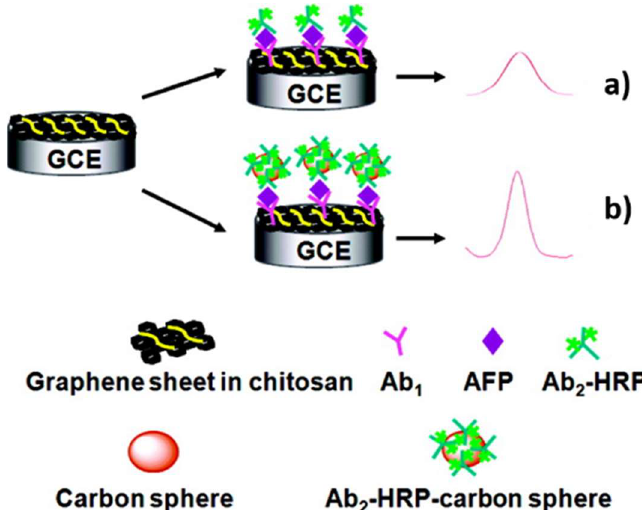
Figure 5. Schematic illustration of the detection principles of HRP-Ab2/AFP/Ab1/GS-CHI/SPCE ( a ) and HRP-Ab2-CNSs/AFP/Ab1/GS-CHI/SPCE; ( b ) using a signal amplification strategy at the graphene sheets biosensor platform. Reproduced from [67], with permission from American Chemical Society, 2010.